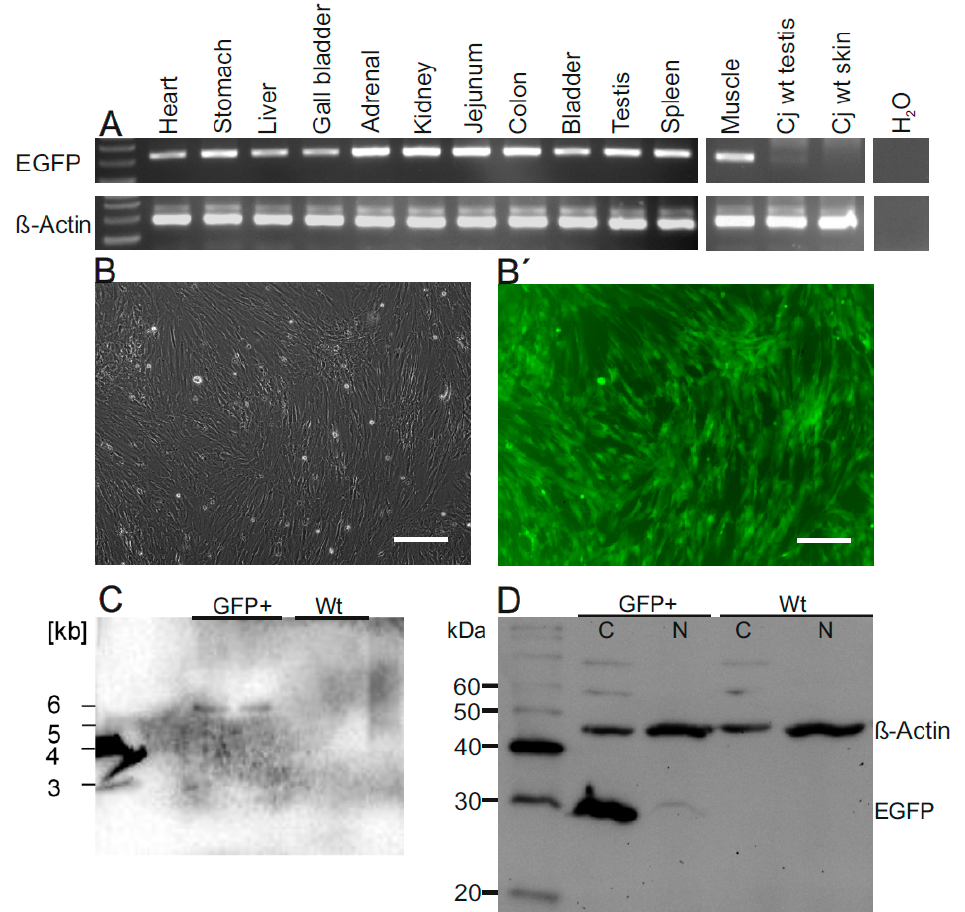
Figure 3. EGFP expression in the deceased neonate #83. (A) The transgene was detected by PCR on genomic DNA in all organs. (B) Bright-field image and (B´) fluorescence image of cultured skin fibroblasts from animal #83. Scale bars: 100 µm. (C) Genomic Southern blot of fibroblast DNA from #83 (GFP+) and from wt fibroblasts using an EGFP -specific probe. Only one band of around 6 kb is visible in the transgenic animal. Samples were loaded in duplicate. (D) EGFP western blot analysis of fibroblast protein from #83 (GFP+) and from wt control. From both samples cytoplasmic (C) and nuclear (N) protein fractions were analyzed. Only the cytoplasmic fraction of the cells of animal #83 showed an EGFP band.